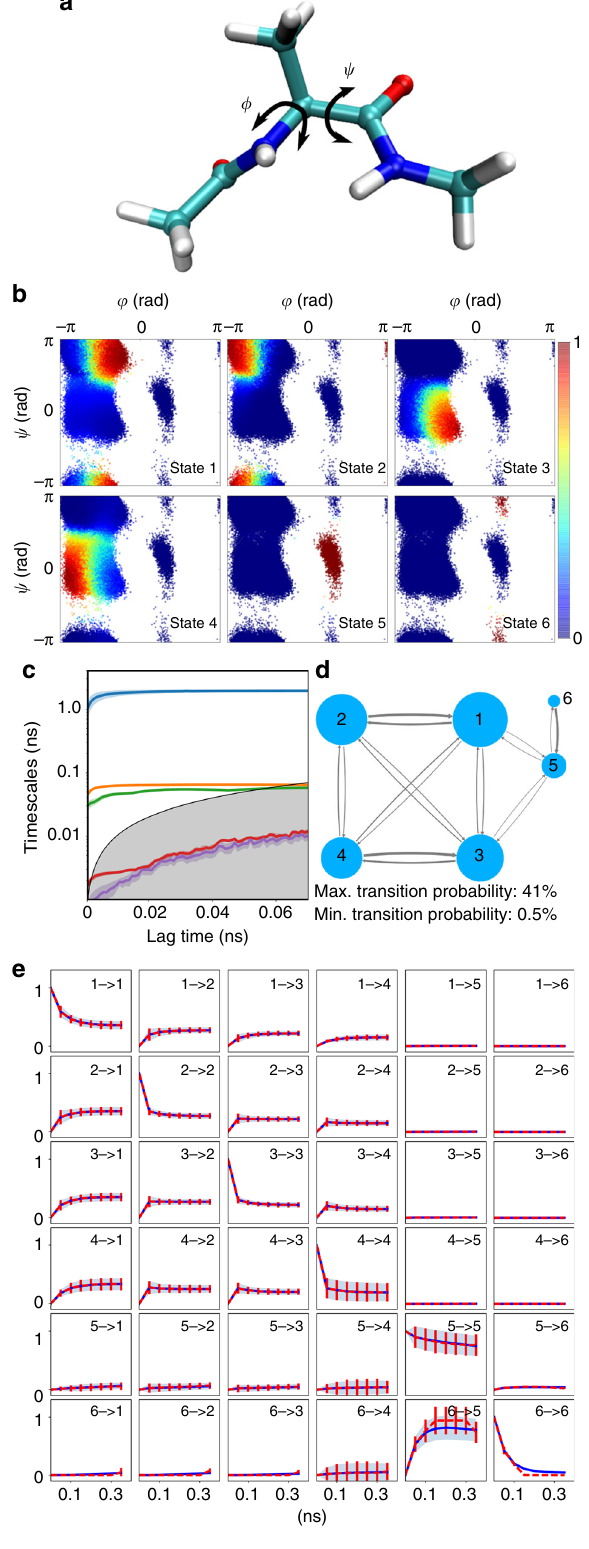
Fig. 4 VAMPnet kinetic model of alanine dipeptide. a Structure of alanine dipeptide. The main coordinates describing the slow transitions are the backbone torsion angles ϕ and ψ , however the neural network inputs are only the Cartesian coordinates of heavy atoms. b Assignment of all simulated molecular coordinates, plotted as a function of ϕ and ψ , to the six Softmax output states. Color corresponds to activation of the respective output neuron, indicating the membership probability to the associated metastable state. c Relaxation timescales computed from the Koopman model using the neural network transformation. d Representation of the transition probabilities matrix of the Koopman model; transitions with a probability lower than 0.5% have been omitted. e Chapman – Kolmogorov test comparing long-time predictions of the Koopman model estimated at τ = 50 ps and estimates at longer lag times. c , e report 95% con fi dence interval error bars over 100 training runs excluding failed runs (see